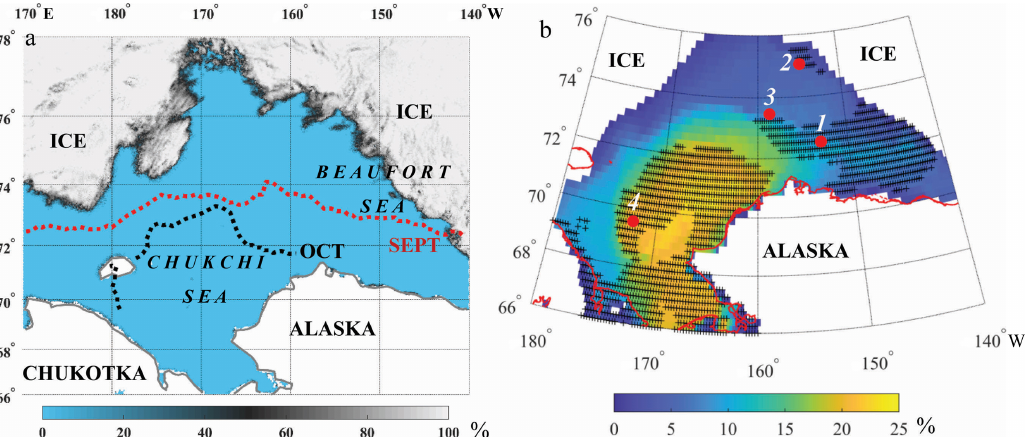
Figure 1. Sea ice concentration on 19 October 2017 ( a ): September (red dotted line) and October (black dotted line) median sea ice edge for 1981–2010 obtained from the National Snow and Ice Data Center (NSIDC) Sea Ice Index, version 3; frequency of favorable conditions for mesoscale cyclogenesis in October 2017 (as a percentage of the month length) ( b ). Hatching areas recorded the highest frequency since 1979. The red circles on ( b ) indicate the location of the PLs formation areas as detected on satellite images: 1—20:16 UTC, October 17, 2—1:59 UTC, October 19, 3—4:23 UTC, October 19, 4—5:02 UTC, October 22.